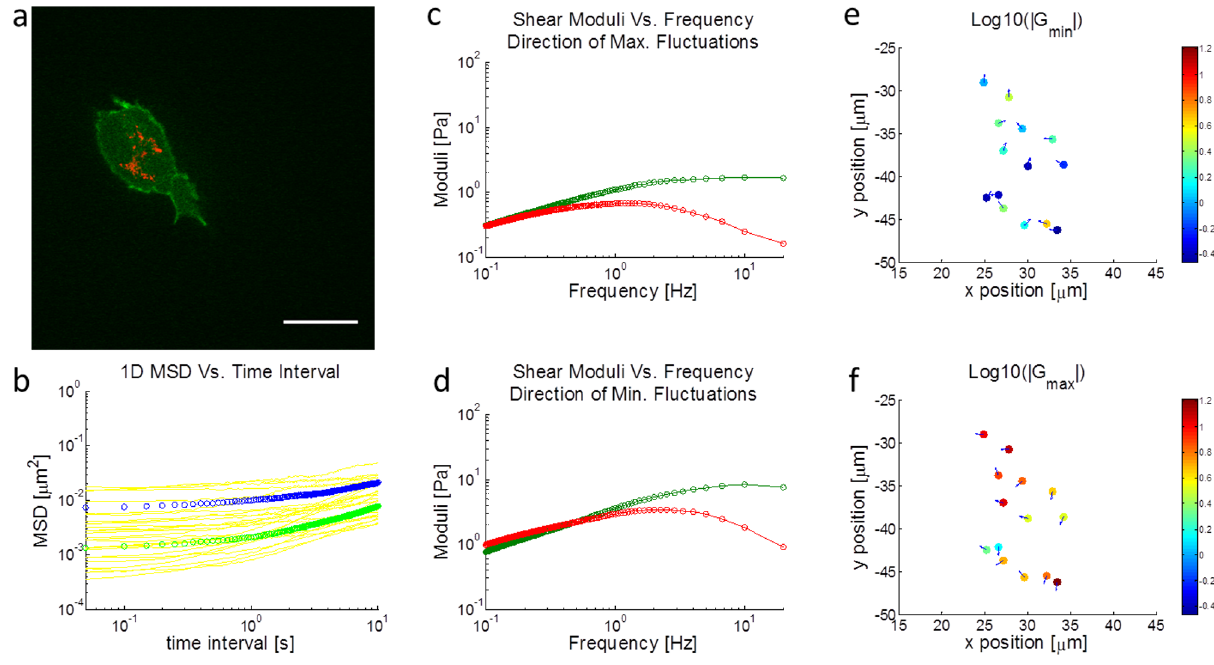
Figure 2. Intracellular microrheology of a single cell in 3D in a microfluidic device. a) Fluorescence image of an MDA-MB-231 cell in 2.5 mg/mL collagen. Actin is green and mitochondria are red. b) 1D MSDs in the two orthogonal directions with the maximum ratio in displacement fluctuations. Blue is the average of the MSDs in the directions of maximum fluctuation and green is the average of the MSDs in the directions of minimum fluctuation. Maximum and minimum directions are determined on a particle by particle basis. Yellow curves represent the 1D MSDs of each individual mitochondrion tracked. c,d) The complex shear modulus G in the directions with maximum (c) and minimum (d) fluctuations. Green is the elastic modulus and red is the loss modulus. e,f) Spatial plots of the log of the magnitude of the shear modulus G in the direction of (e) maximum and (f) minimum fluctuations at 10 Hz. Arrows point in the directions with the maximum (e) or minimum (f) fluctuations. Colors represent the magnitudes of log|G|. This experiment was performed at ambient conditions. The scale bar is 20 m m.